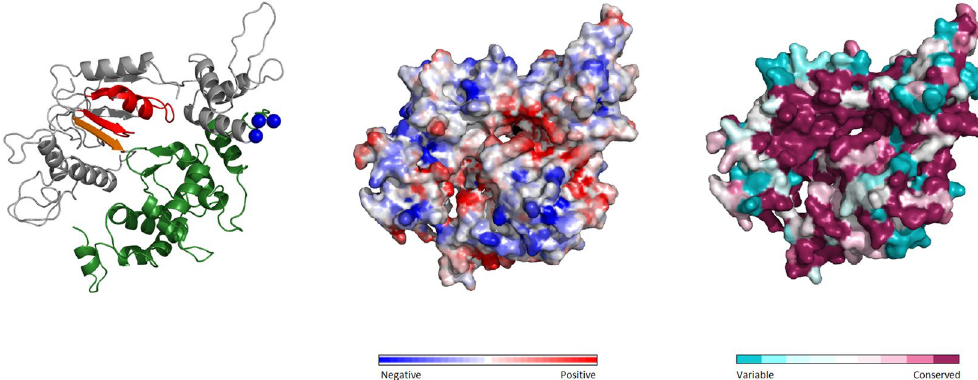
Figure 3. Structural analysis of ATPase domain in TANC1. Cartoon of TANC1 ATPase domain model (front part) is coloured as following: Walker motifs is in red, ASCE in orange, HETHS domain in green, GxP motif in blue spheres. Electrostatic properties of front surfaces are shown: negative charges in blue and red charges in red. ConSurf analysis of front surfaces, colour code from unconserved (cyan) to conserved (purple)